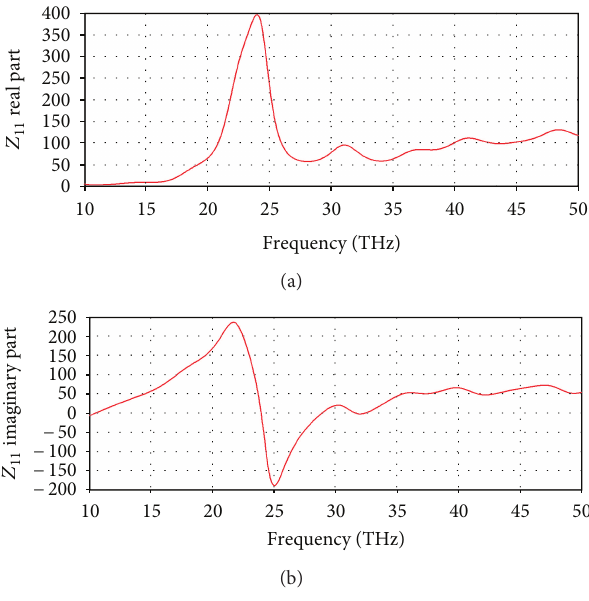
Figure 10: Input impedance of Archimedean spiral antenna: (a) resistance and (b) reactance.